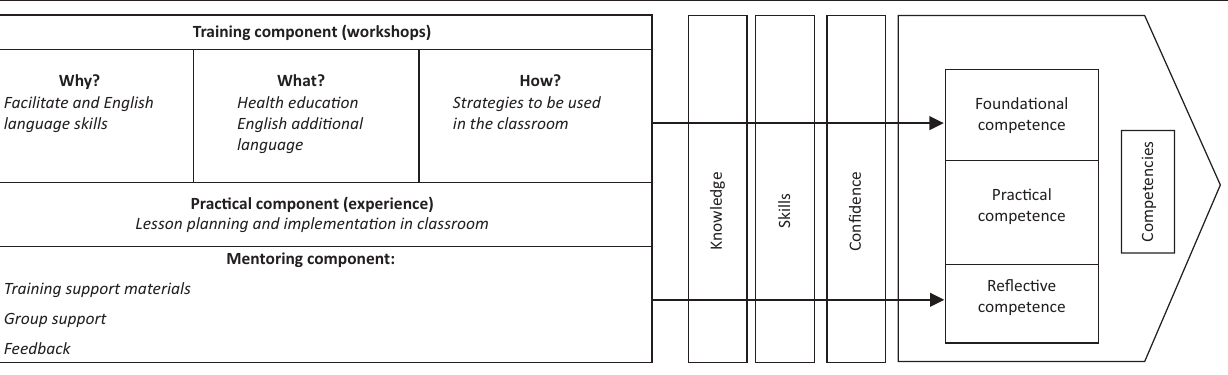
FIGURE 1: Three-pronged approach to educator